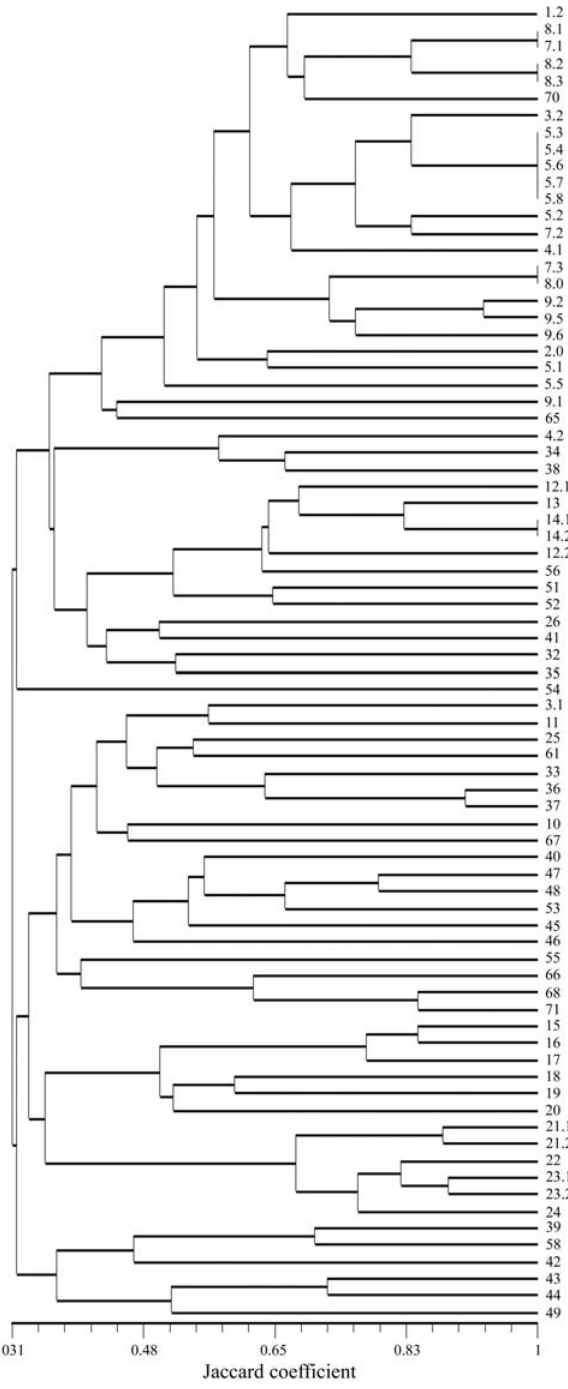
Figure 2 - Dendrogram showing 78 sweet potato ( Ipomoea batatas ) ac- cessions (landraces and putative clones) from the Vale do Ribeira, São Paulo, Brazil.